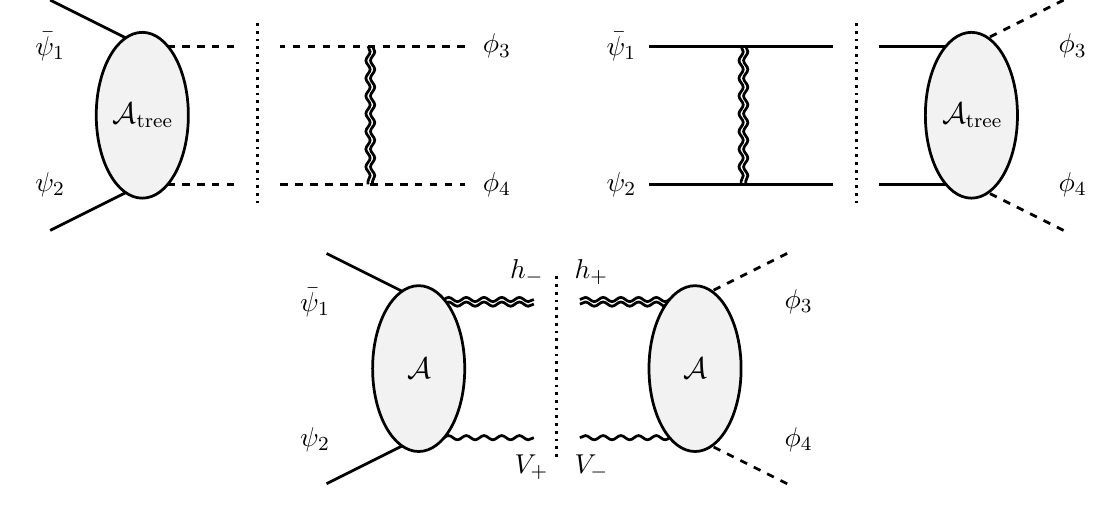
Figure 5 . Cut diagrams corresponding to the r.h.s. of eq.